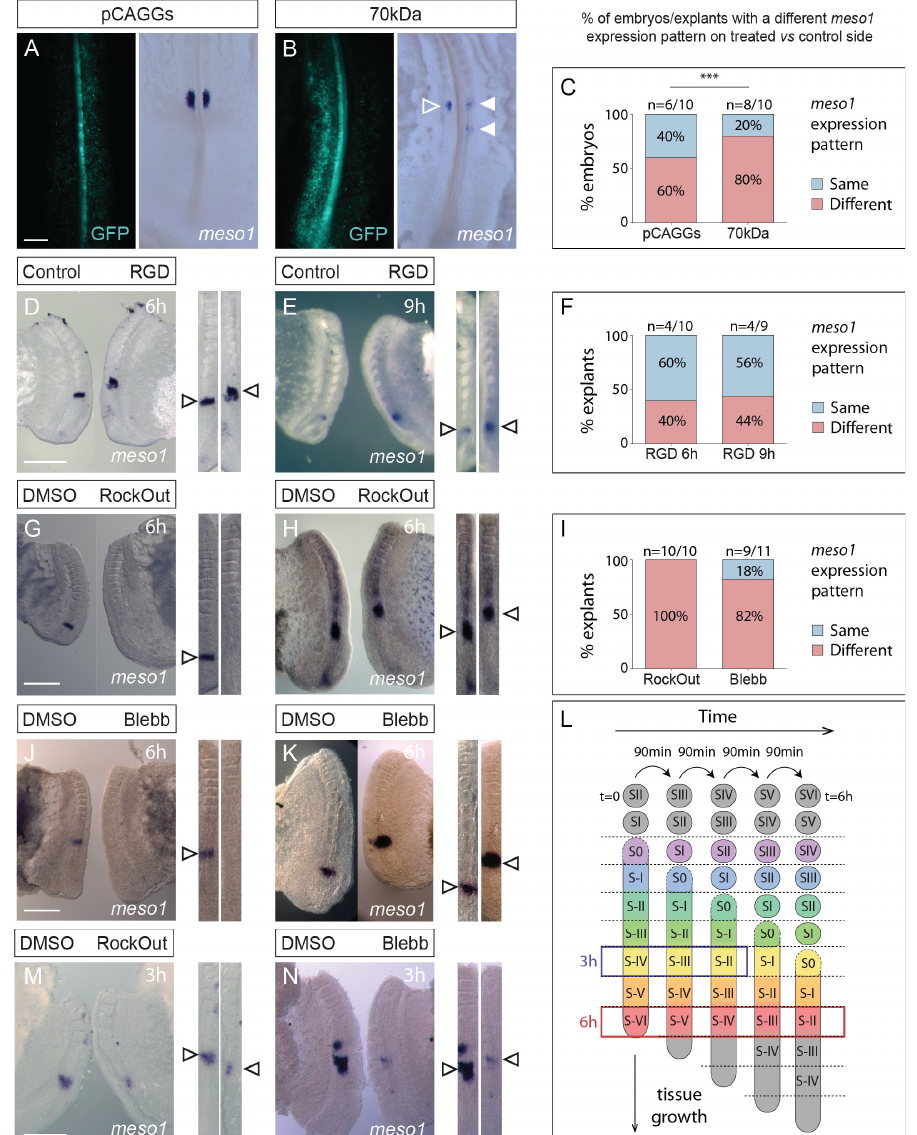
Figure 5. Meso1 expression is altered in 70 kDa-electroporated embryos and explants cultured with RGD, RockOut or Blebbistatin. In situ hybridization for meso1 on embryos electroporated with the pCAGGS or 70 kDa ( A , B ) and on explant cultures testing the effect of RGD ( D , E ), RockOut ( G , H , M ) or Blebbistatin ( J , K , N ). Straightened images of the paraxial mesoderm of contralateral explant pairs were aligned by SIV (right, D , E , G , H , J , K , M , N ) to assess whether the meso1 expression pattern was the same or different on the two contralateral sides. Rostral is on top. Quantification of the percentage of PSM pairs with different expression patterns ( C , F , I ). Example of a pCAGGs-electroporated control embryo with the same meso1 expression pattern on both sides ( A ) and a 70 kDa-electroporated embryo where the electroporated side (left) has a different meso1 pattern from the non-electroporated side (solid vs. open arrowheads in B ). The percentage of 70 kDa-electroporated embryos with a different meso1 pattern on the electroporated side is significantly higher than with pCAGGs. Meso1 expression patterns in RGD-treated explants after 6 ( D ) or 9 h ( E ) of culture are different from their contralateral controls in 40%–44% of cases ( F ). Examples of meso1 expression patterns in RockOut- ( G , H ) and Blebbistatin-treated ( J , K ) explants compared to that of their contralateral control (DMSO) sides (arrowheads, G , H , J , K ). In total, 100% of RockOut-treated and 82% of Blebbistatin-treated explants displayed a different pattern than the contralateral control after 6 h of culture ( I ). RockOut- and Blebbistatin-treated explants incubated for 3 h also produced different meso1 expression patterns compared to the controls (arrow- heads, M , N ). ( L ) Representation of explant analysis in experiments with 3 and 6 h culture periods. Meso1 is induced in S-II. When the treatment was added 6 h earlier, the perturbation of meso1 expression